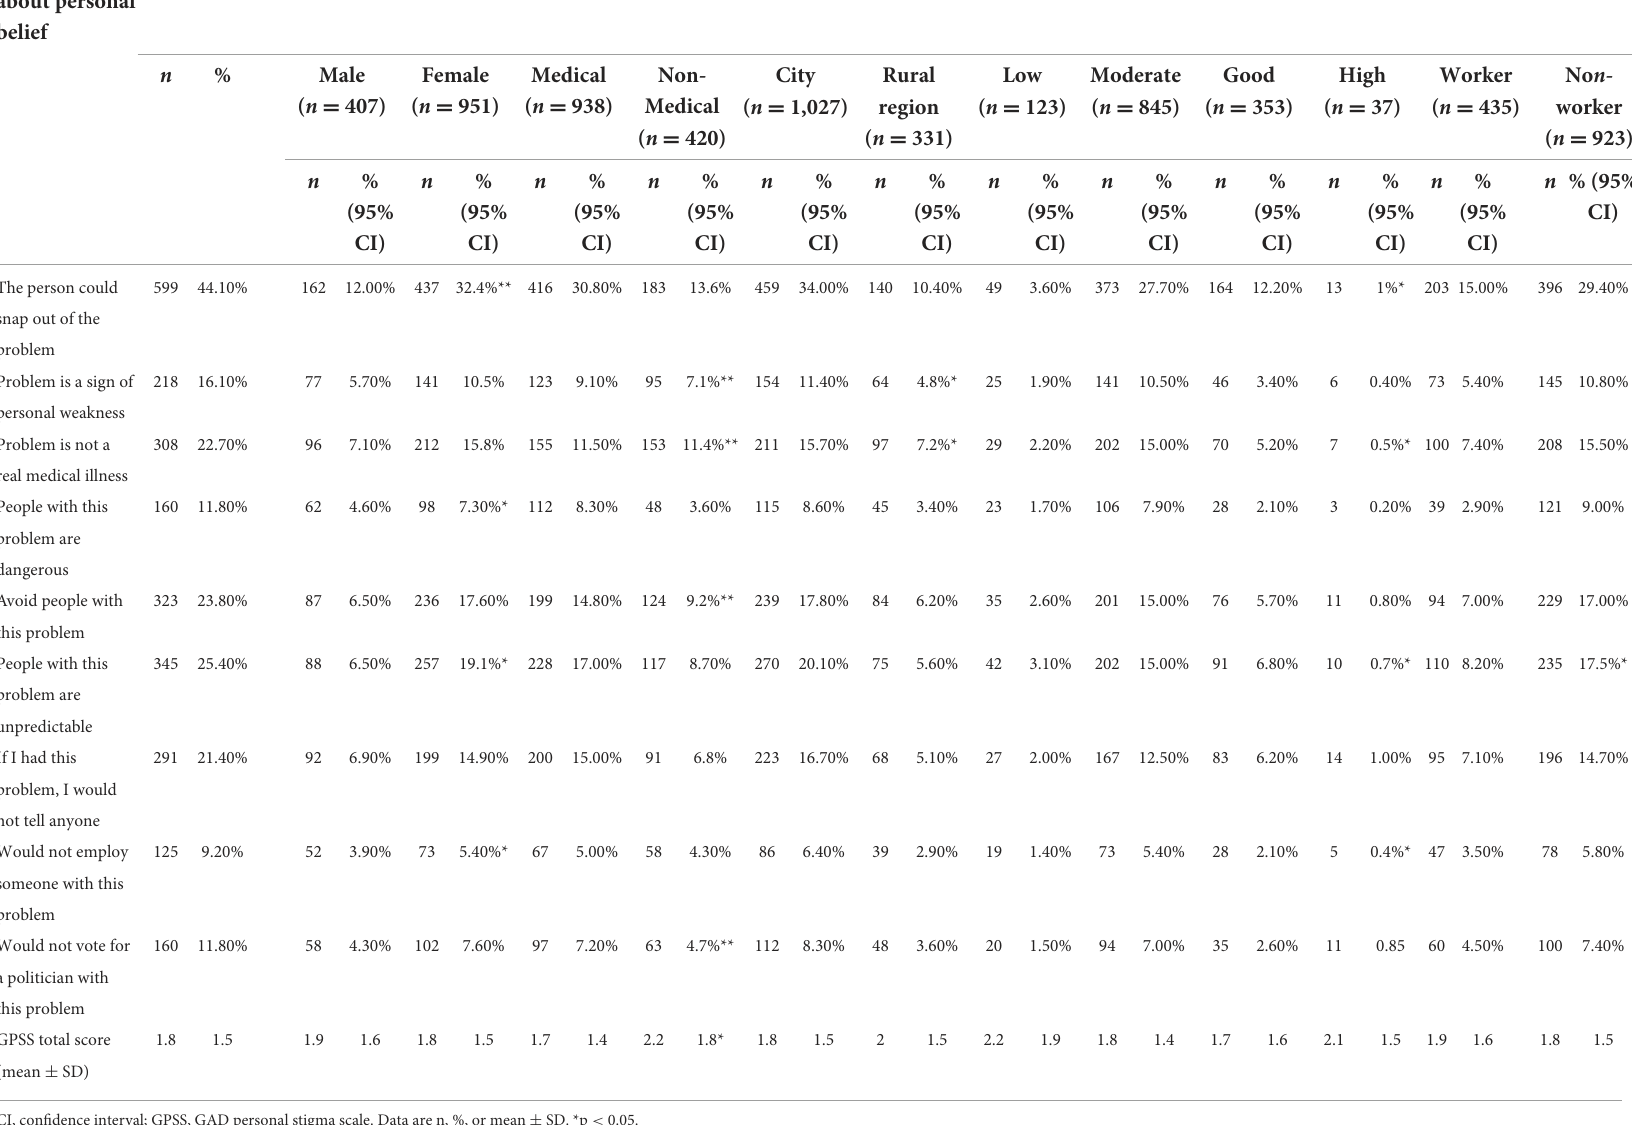
TABLE 2 Percentage of participants who “agree” or “strongly agree” with personal stigma toward GAD patient scale